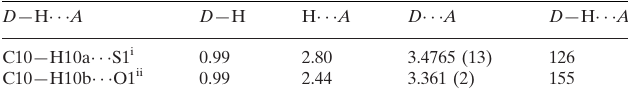
Hydrogen-bond geometry (A˚ , (cid:2)